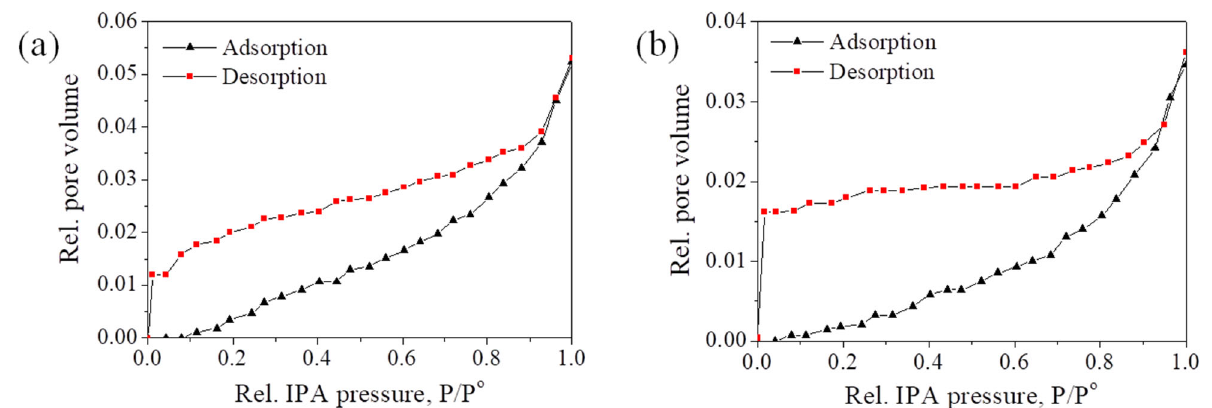
Figure 6. Adsorption and desorption curves of isopropyl alcohol (IPA) on the surface of SiCN films deposited using BTMSPA/He mixture at 100 ( a ) and 400 °C ( b ).